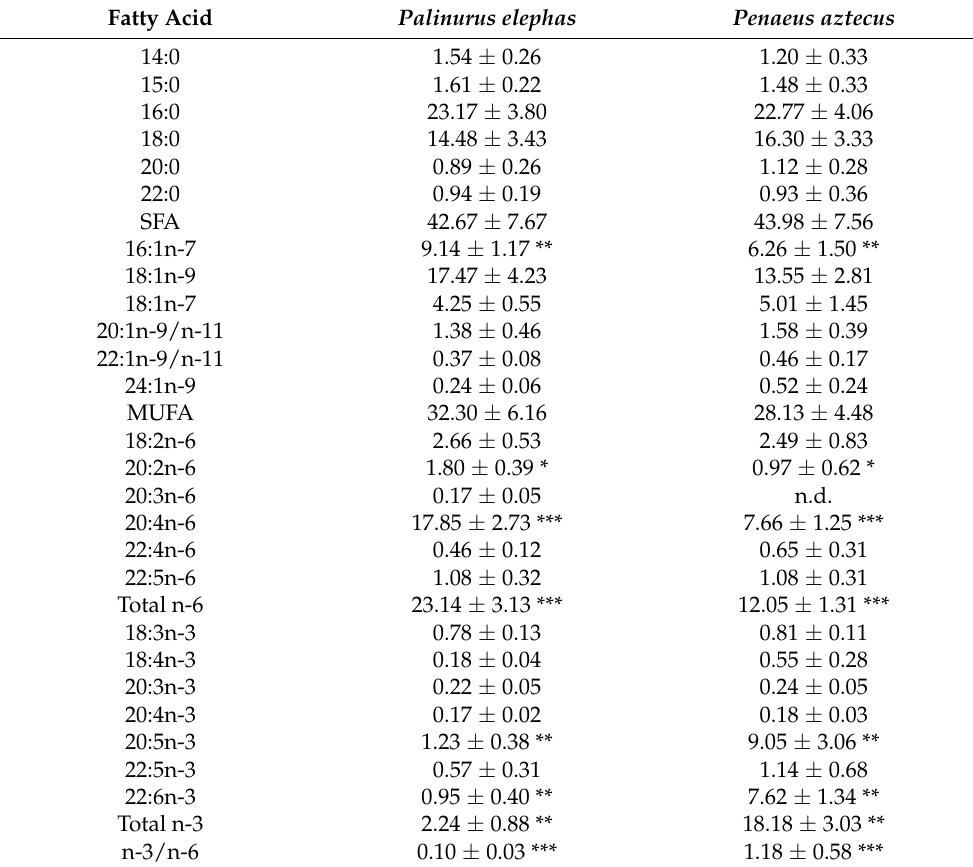
Table 4. Fatty acid composition (percentage of total fatty acids) of the muscle tissue of Palinurus elephas and Penaeus aztecus . Fatty